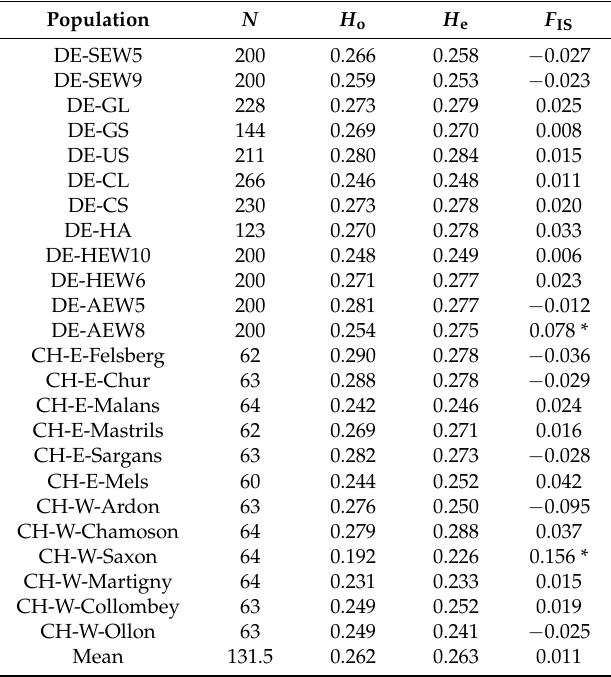
Table 5. Genetic diversity indices based on